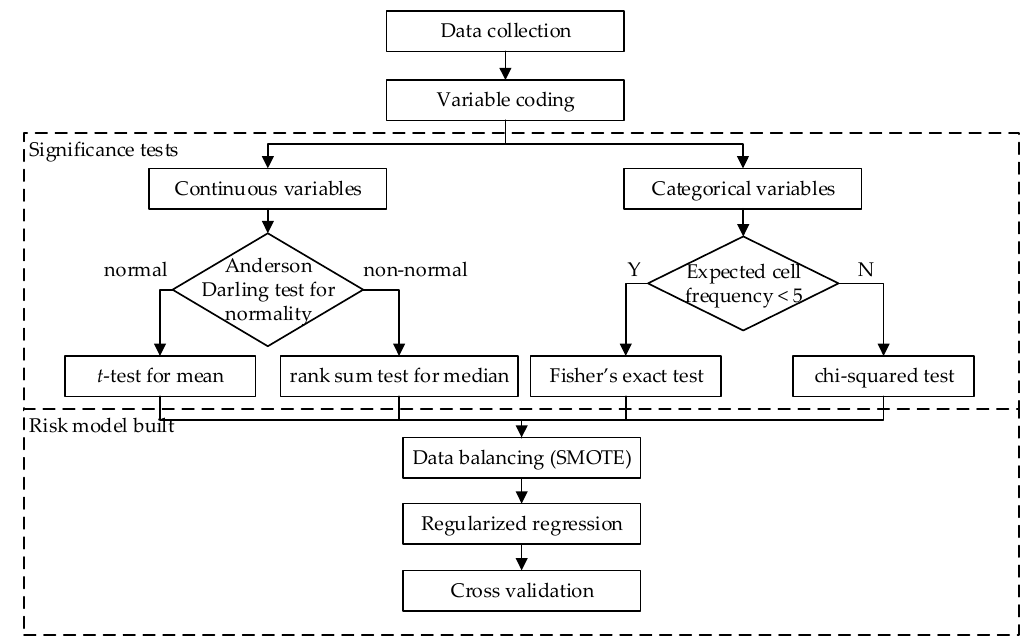
Figure 1. The flowchart of the proposed method.